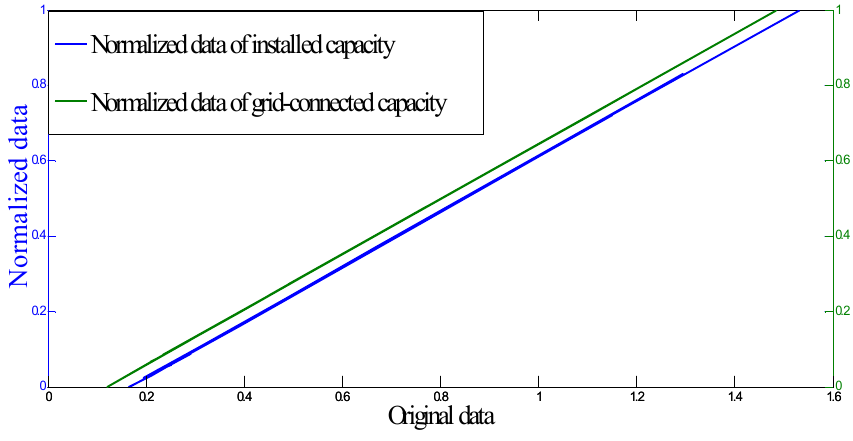
Figure 6. The pretreatment results of raw data.